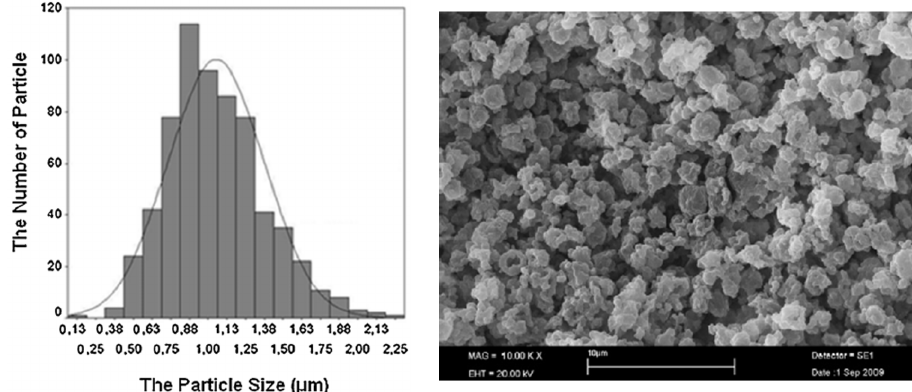
Figure 11. The PSD ( left ) and SEM image ( right ) of PMMA/n-hexadecane microcapsules produced using allyl-methacrylate [118]. Reproduced with permission from Elsevier.